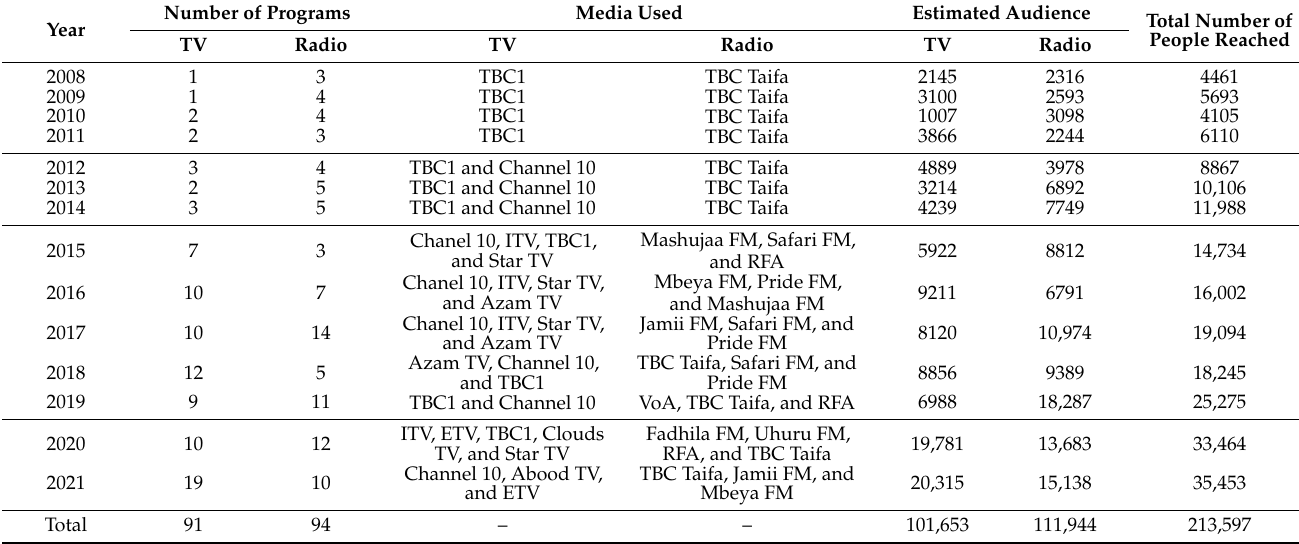
Table 8. Number of TV and radio programs used and audience